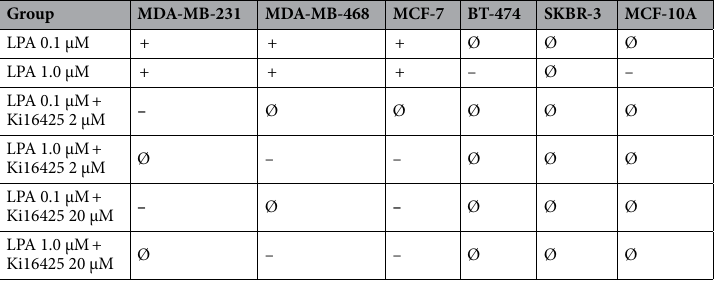
expressed in MDA-MB-231 cells, whereas LPAR2 was particularly expressed in MCF-7 cells. LPAR3 was pre-